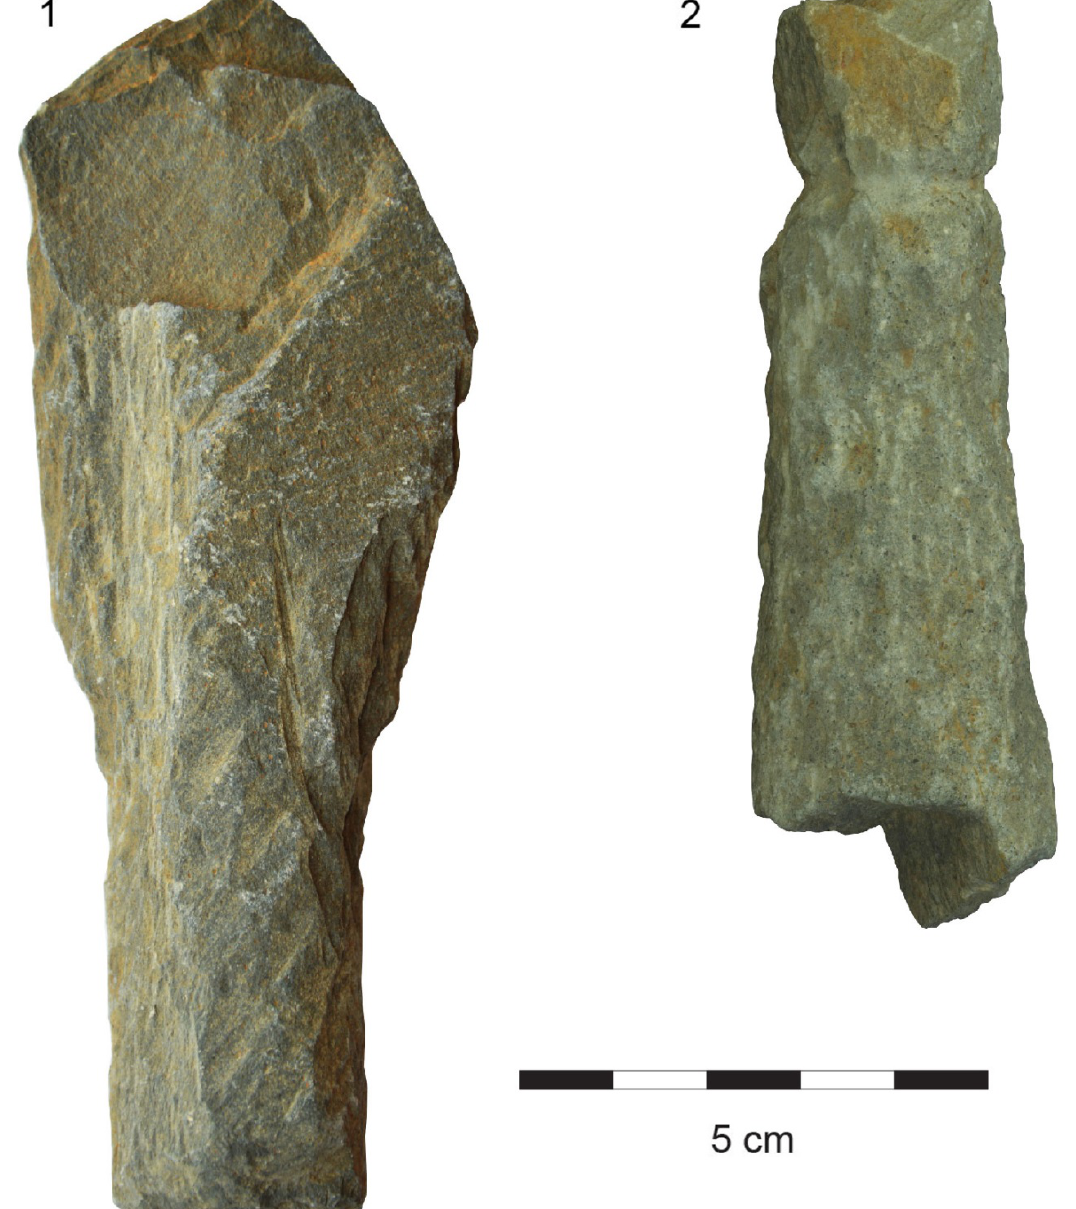
Figure 13: Unworked grips of rough-outs from (1) Le Châtelet-sur-Sormonne and (2) Buizingen. The groove of the Buizingen example was cut to remove the grip.